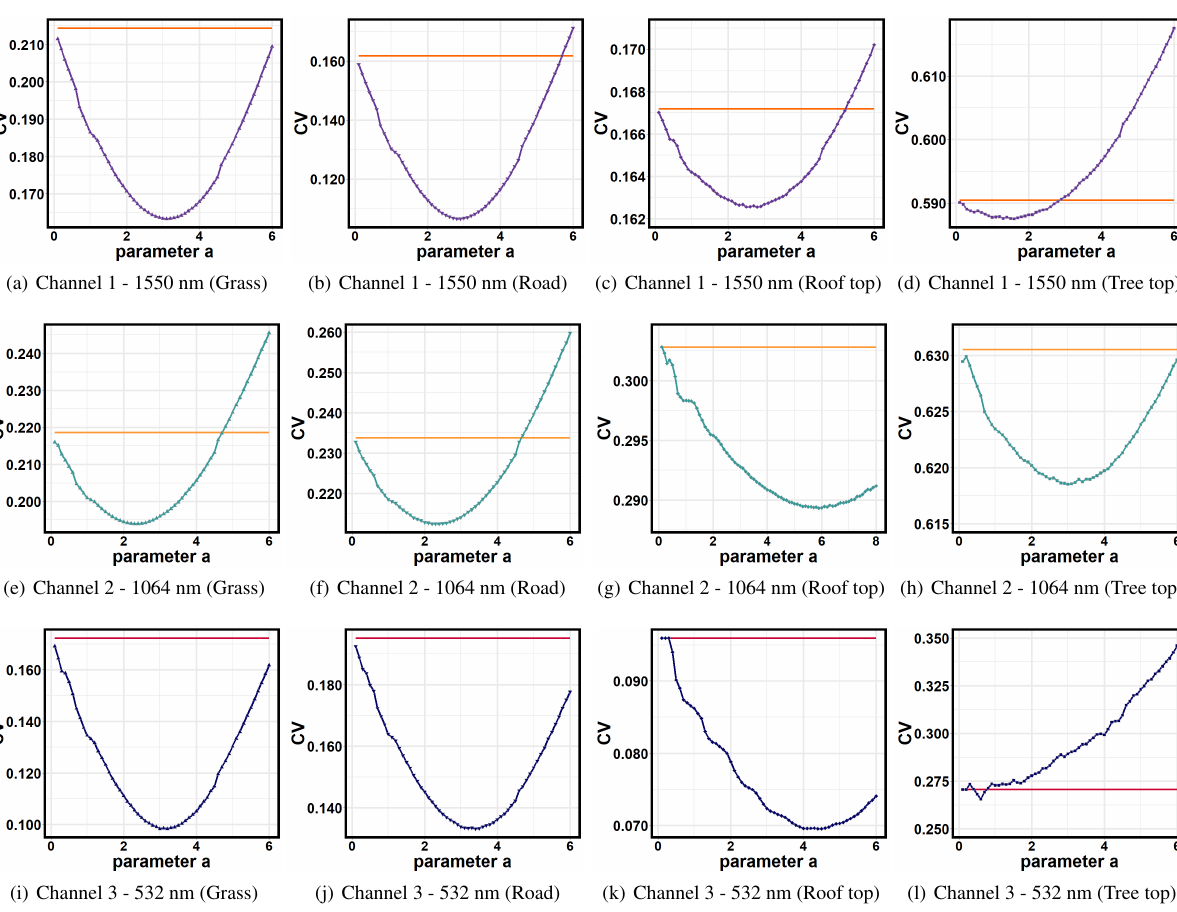
Figure 4. Results of range normalization on overlapping LiDAR data strips: cv against the parameter a